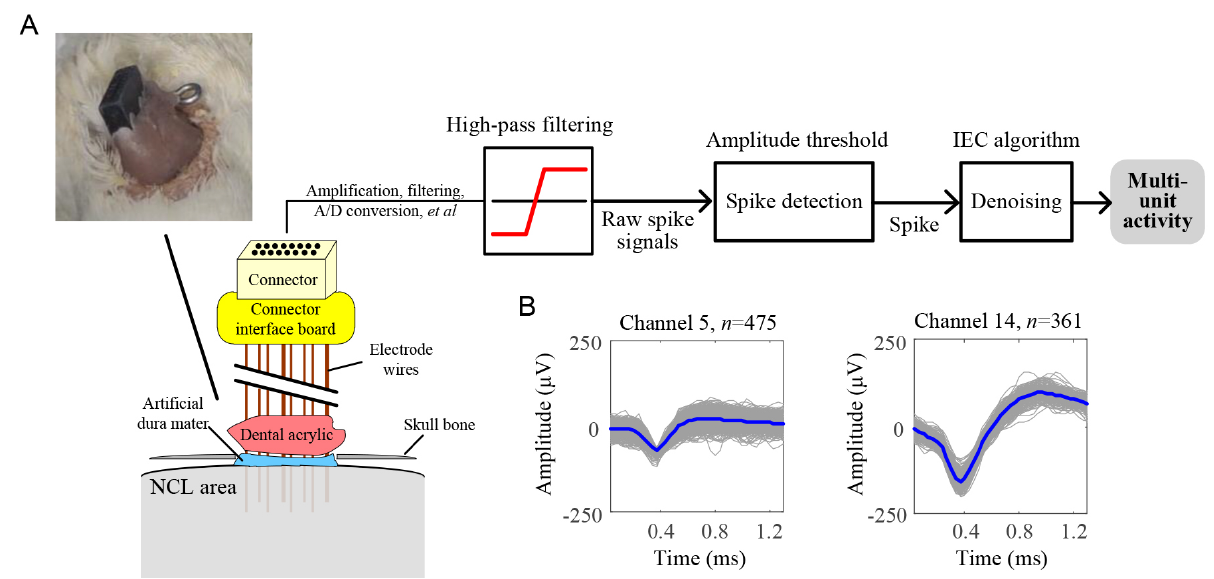
Fig. 2. Data acquisition and processing. (A) Data acquisition and processing flow. A photograph of the implanted microelectrode array is shown in the upper left corner. (B) Spike waveforms of two typical channels after processing. The mean spike waveform is highlighted in blue.